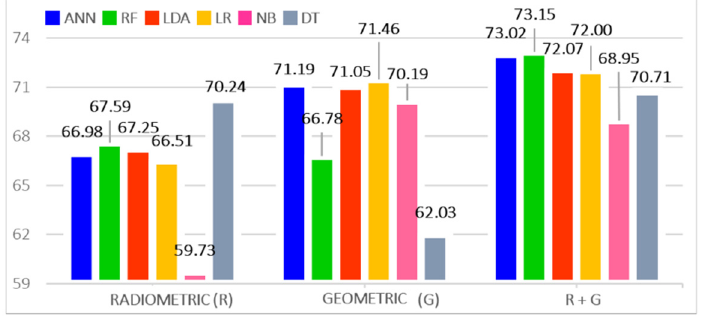
Figure 5. ML algorithm performances for geometric and radiometric attributes, individually pro- cessed and integrated, including maximum and average values as reference.